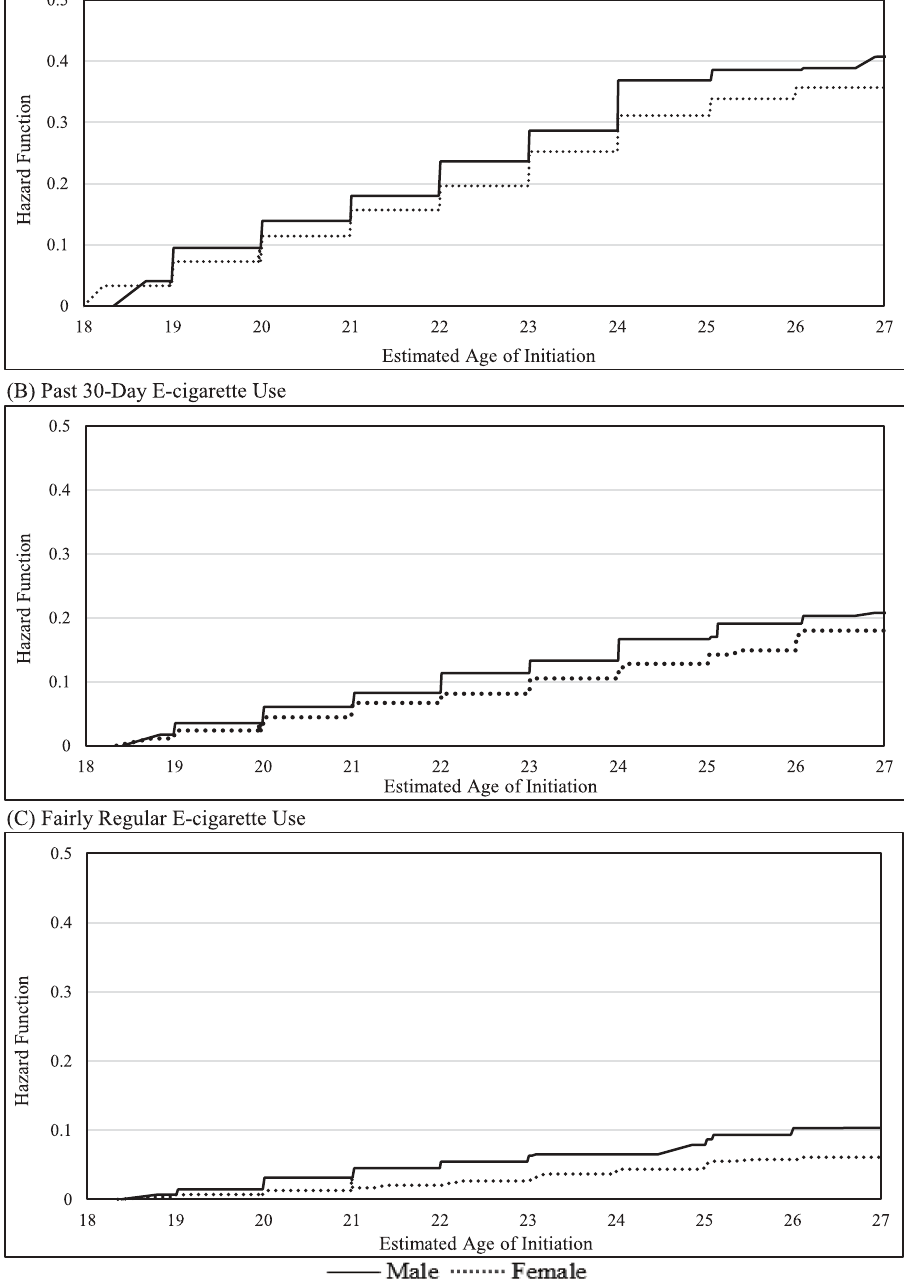
Fig 2. Estimated age of e-cigarette initiation in PATH young adults stratified by sex. Hispanic Black (8.6%), and ages 22 and 23 (5.8%) for Non-Hispanic other young adults. By age 25, 14.1%, 20.8%, 13.6%, and 14.4% of Non-Hispanic White, Hispanic, Non-Hispanic Black, and Non-Hispanic other young adults initiated past 30-day e-cigarette use. The largest increase in past 30-day e-cigarette initiation occurred between ages 20 and 21 for Non-